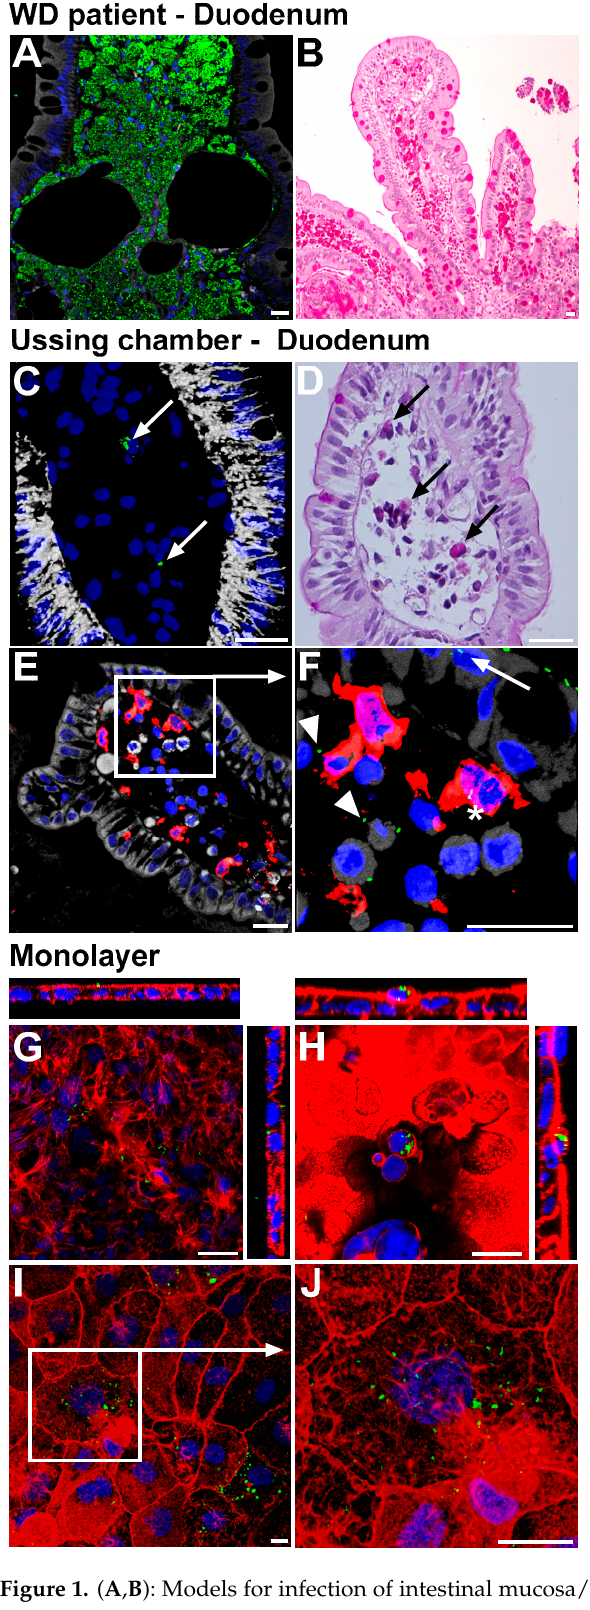
Figure 1. ( A , B ): Models for infection of intestinal mucosa/epithelia by T. whipplei . Representative section of an untreated WD patient at time of diagnosis, exhibiting a massive infiltration of duodenal lamina propria (LP) macrophages with TW . Immunofluorescence staining (IF), green: TW , white: F-actin, blue: nuclei ( A ). Periodic acid-Schiff (PAS) staining ( B ). ( C – F ): Sections (IF and PAS) of